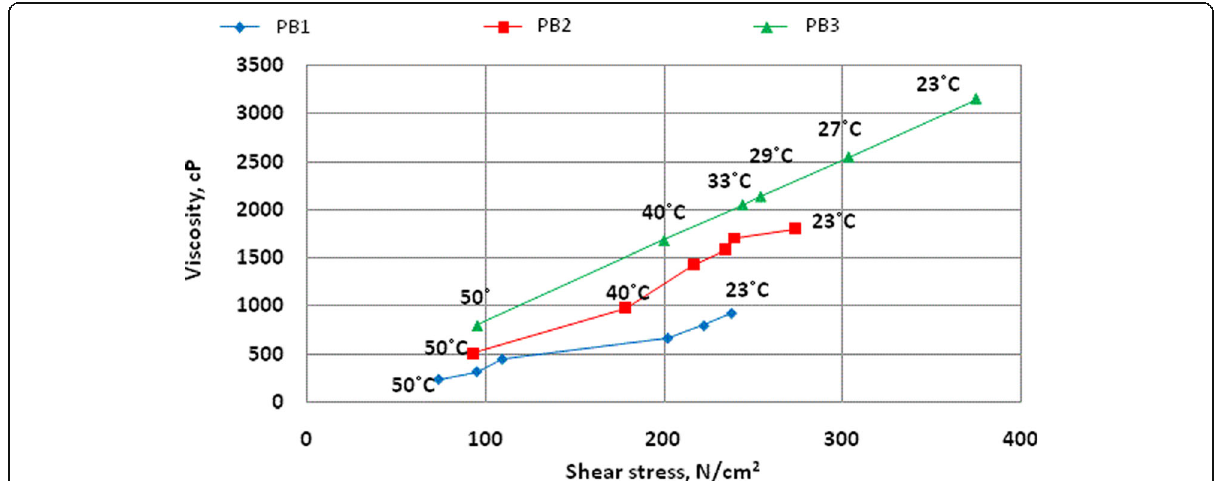
Fig. 10 Polymer blends at different temperatures